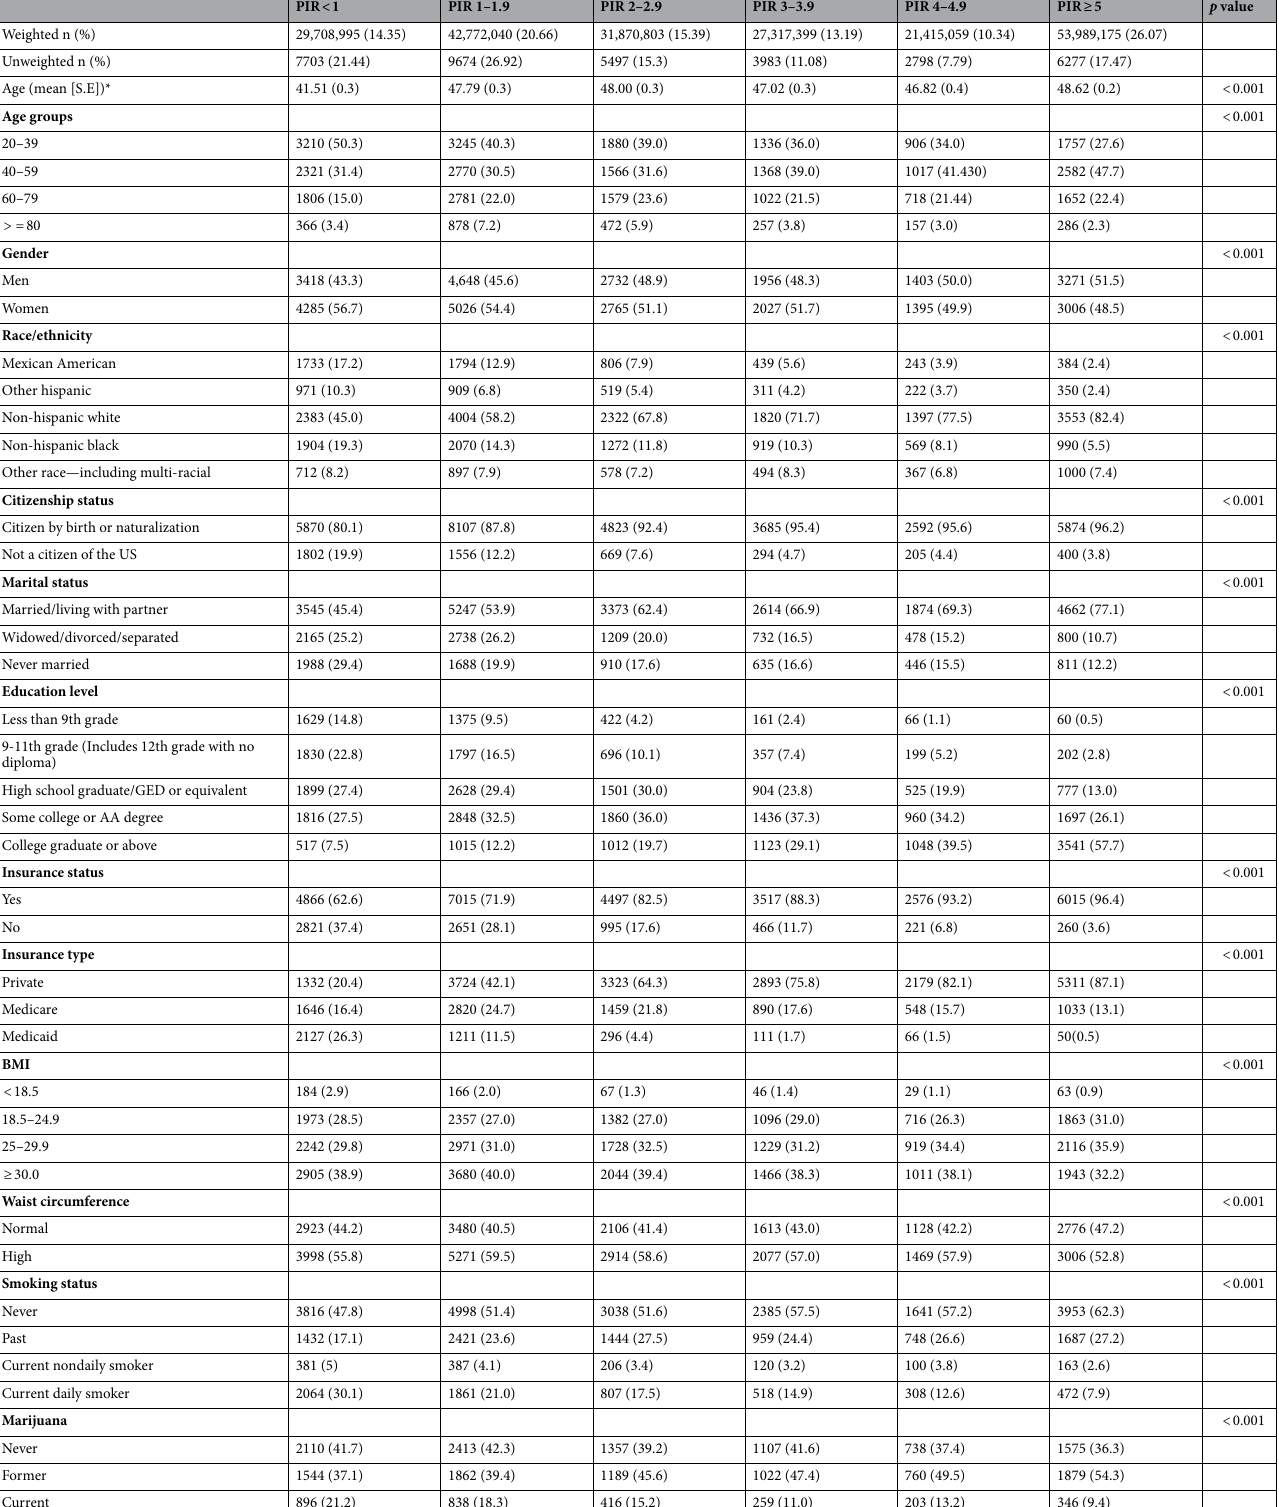
Table 1. Baseline and Demographic characteristics of participants stratified by PIR. Variables. *Data are presented as unweighted n (weighted percentage) for categorical variables and weighted mean and s.e for continuous variables. Key: PIR : Family poverty to income ratio, SE : standard error, US : United States, GED : general education development, AA : associate of arts, BMI : body mass